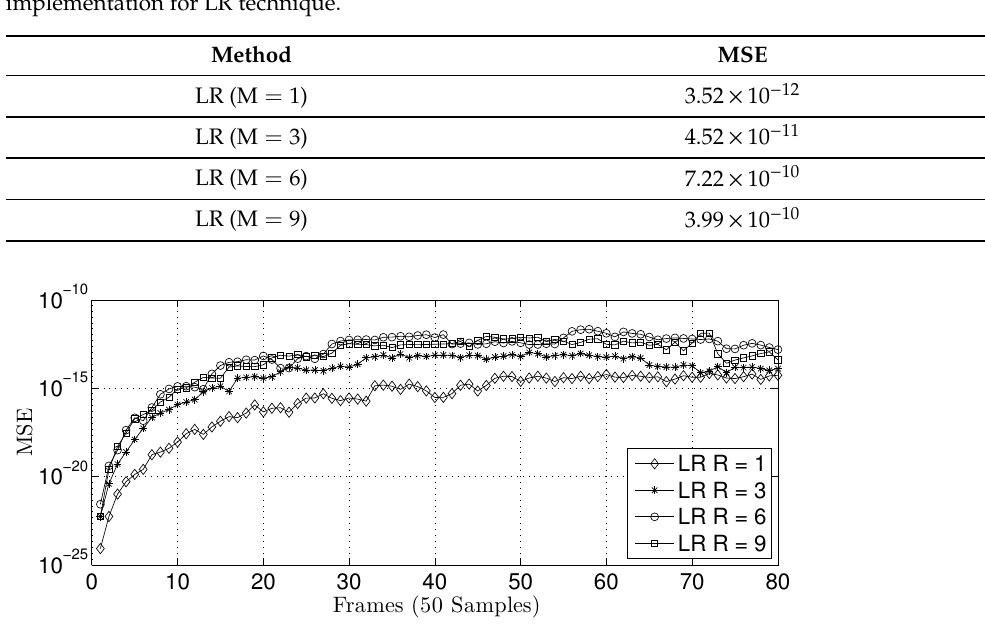
Figure 31. Comparison of the MSE value between the implemented linear prediction